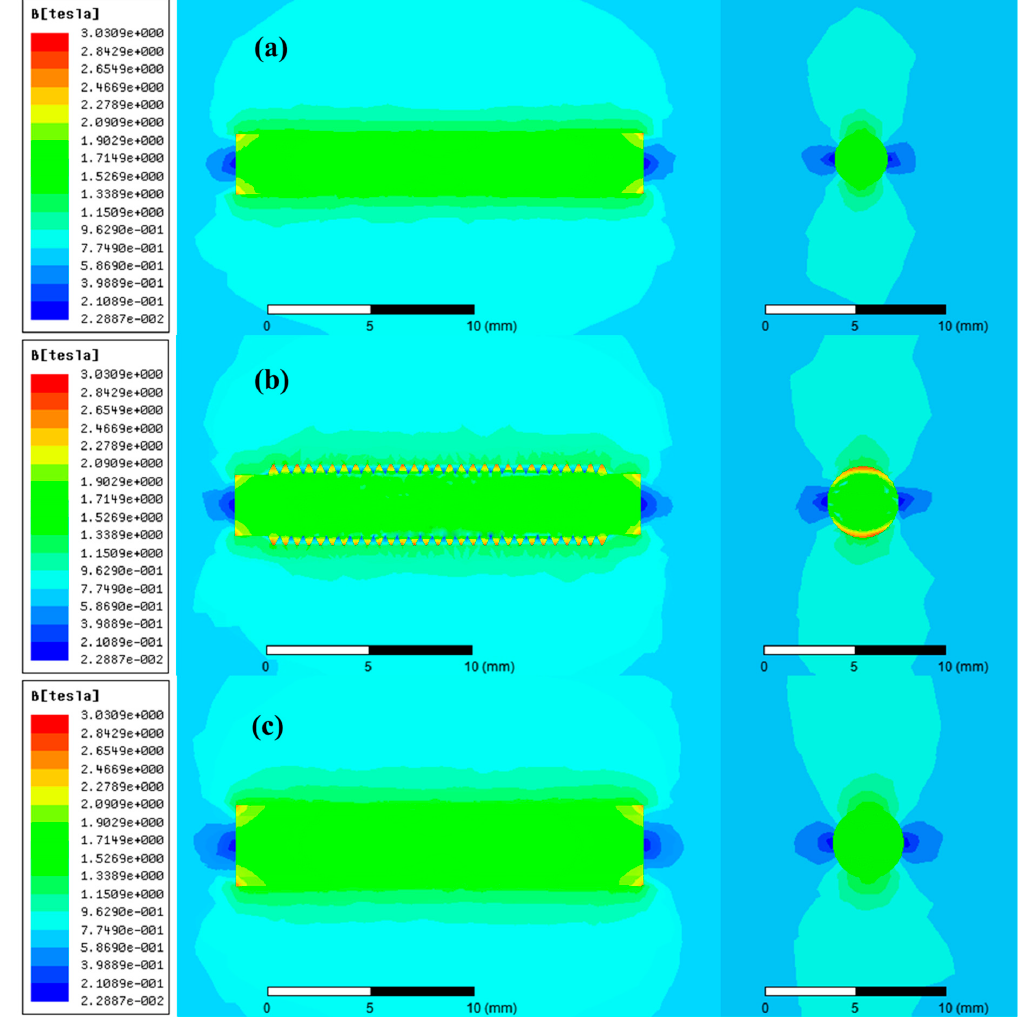
Figure 7. The cloud chart of magnetic induction intensity distribution in the axial and radial directions. ( a ) The smooth rod matrix with a diameter of 3 mm. ( b ) The screw thread rod matrix. ( c ) The smooth rod matrix with a diameter of 3.5 mm.